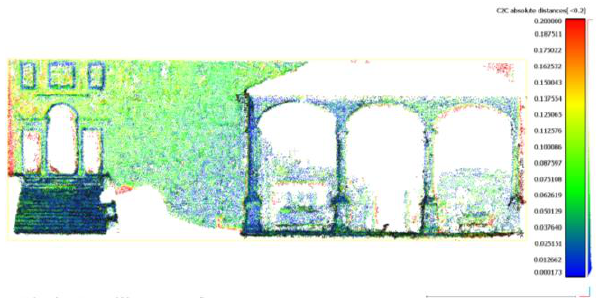
1:200 representation scale. In Figure 18 the discrepancies between the clouds are shown.